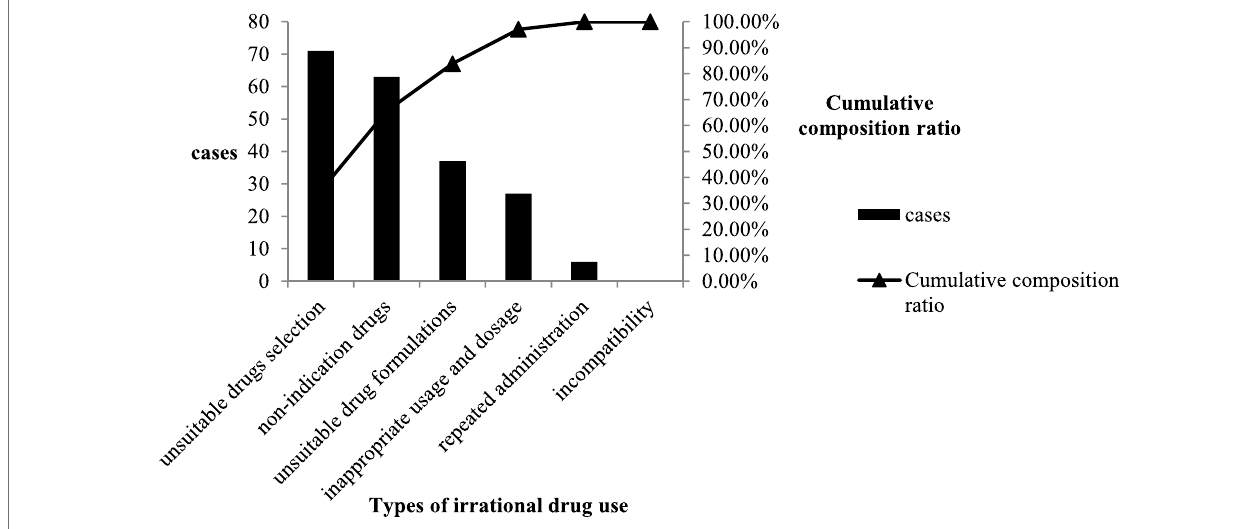
FIGURE 2 | Pareto chart of types of irrational drug use in the control group.